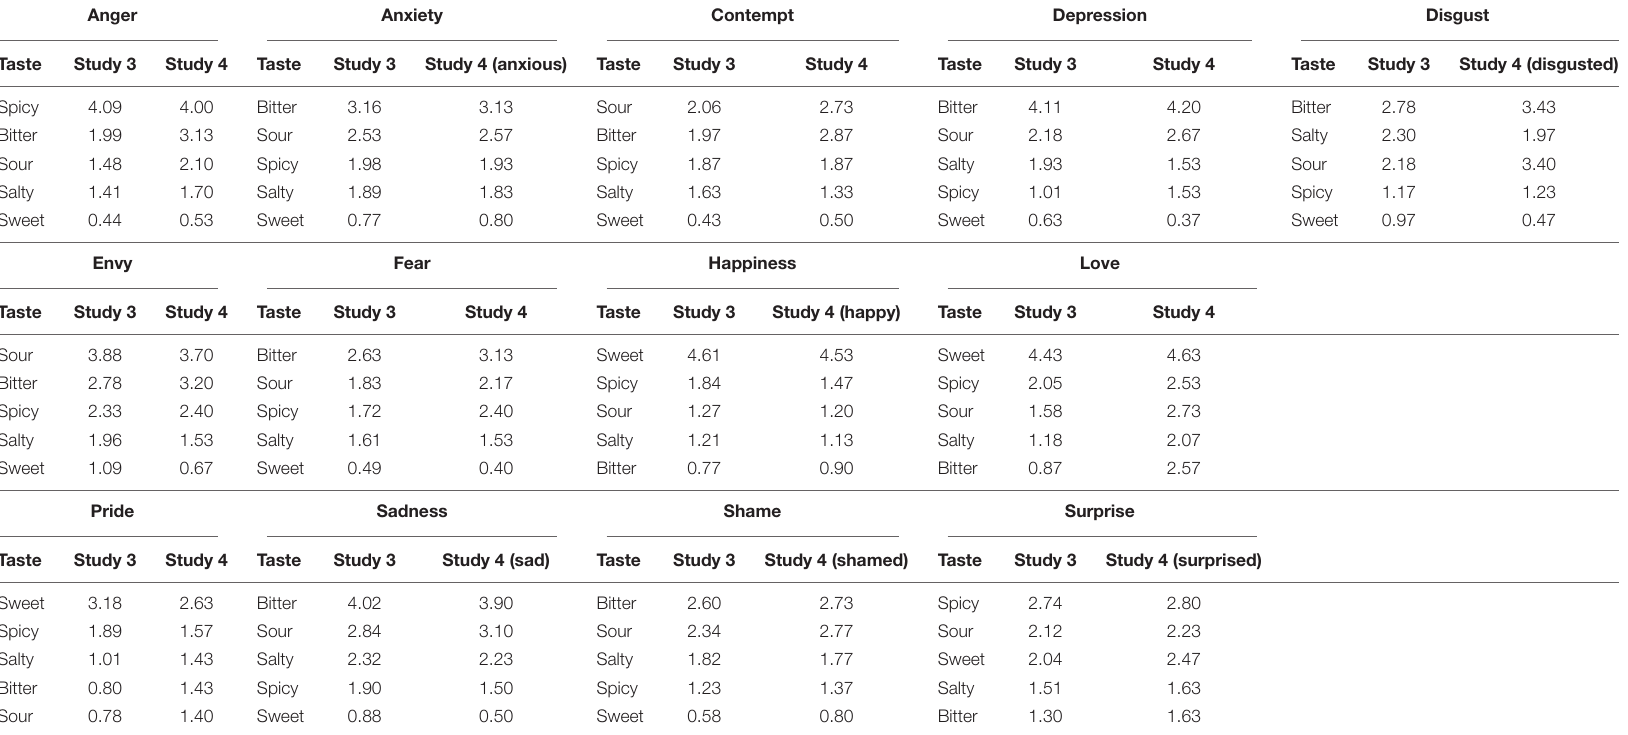
TABLE 5 | Comparison on means for the association strength of five tastes and 13 basic emotion from study 3 and study 4. Anger Anxiety Contempt Depression Disgust Taste Study 3